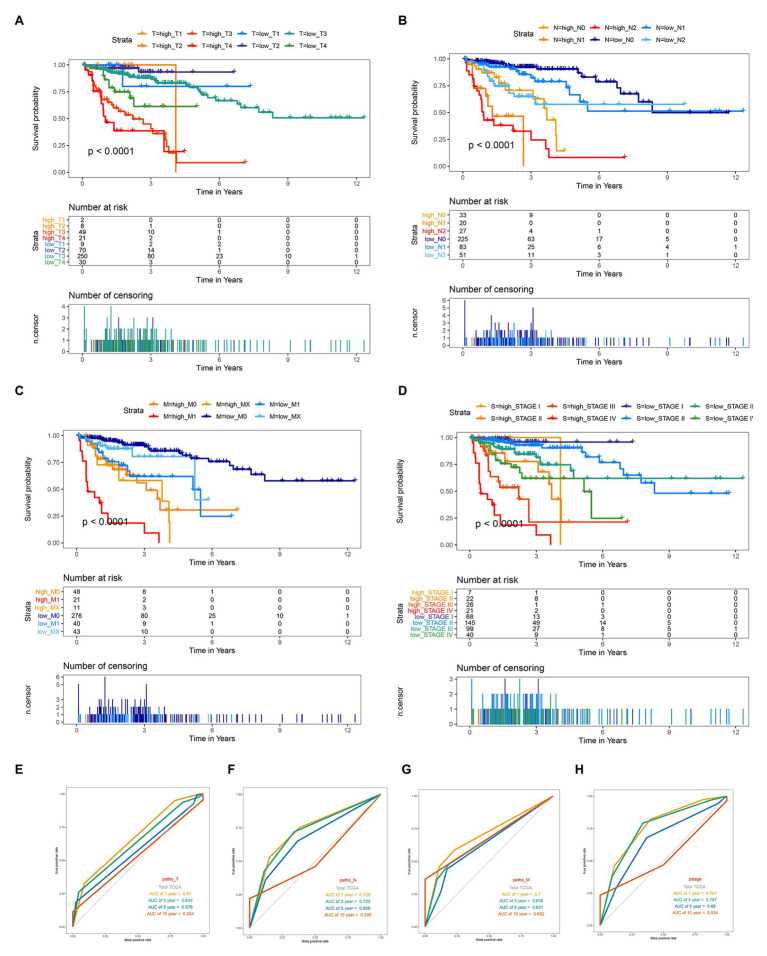
Kaplan-Meier survival for OS in high-risk and low-risk group of different subgroup and ROC curve analysis of T, N, M and stage in the total TCGA cohort. (A) In subgroups stratified by T1, T2, T3, and T4. (B) In subgroups stratified by N0, N1, and N2. (C) In subgroups stratified by M0, M1, and MX. (D) In subgroups stratified by stage I, stage II, stage III, and stage IV. (E–H) ROC curve analysis of T, N, M and stage according to the 1, 3, 5, and 10-year survival of the area under the AUC value in the total TCGA cohort.